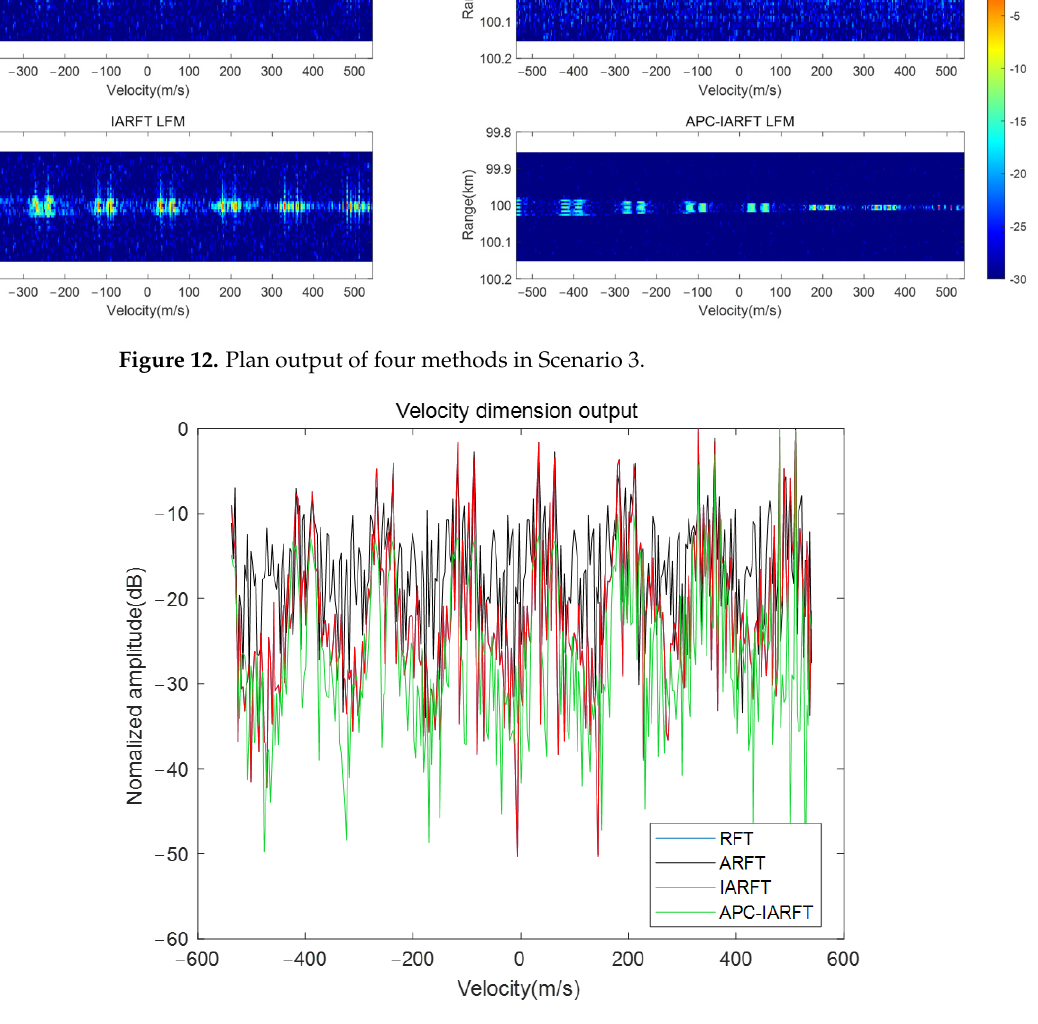
Figure 13. Velocity-dimension output of four methods in Scenario 3. Table 6. APSL 2D and APSL v of the targets set in Scenario